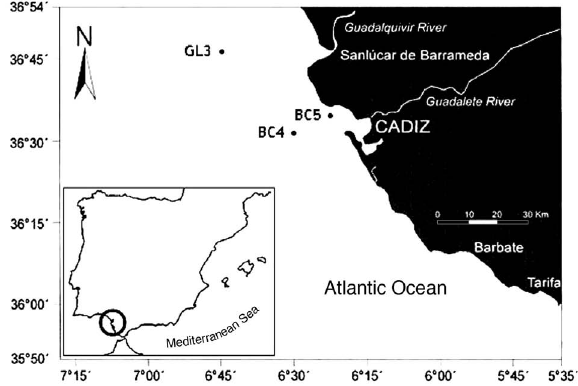
Fig . 1. – Location of the study area and sampling area on the north- ern shelf of the Gulf of Cádiz (SW Spain). Sediment cores BC4 and BC5 were obtained from the outer Bay of Cádiz, whereas core GL3 was obtained from the submarine prodelta of the River